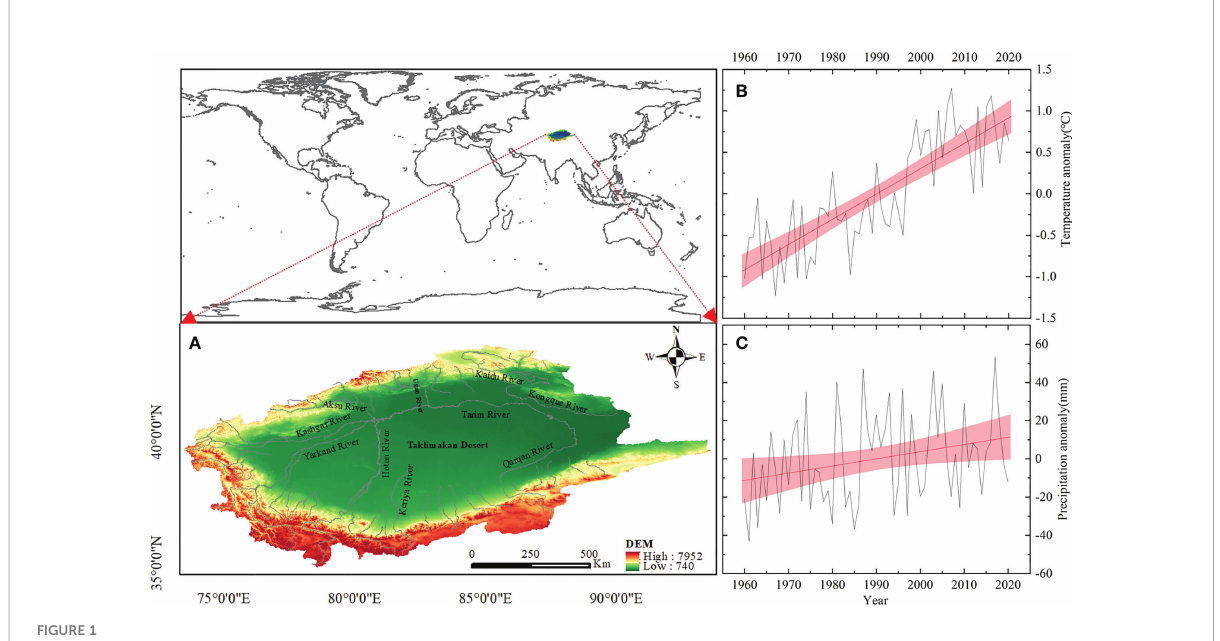
FIGURE 1 Map of the study area (A) , temperature trend (B) and precipication trend (C)